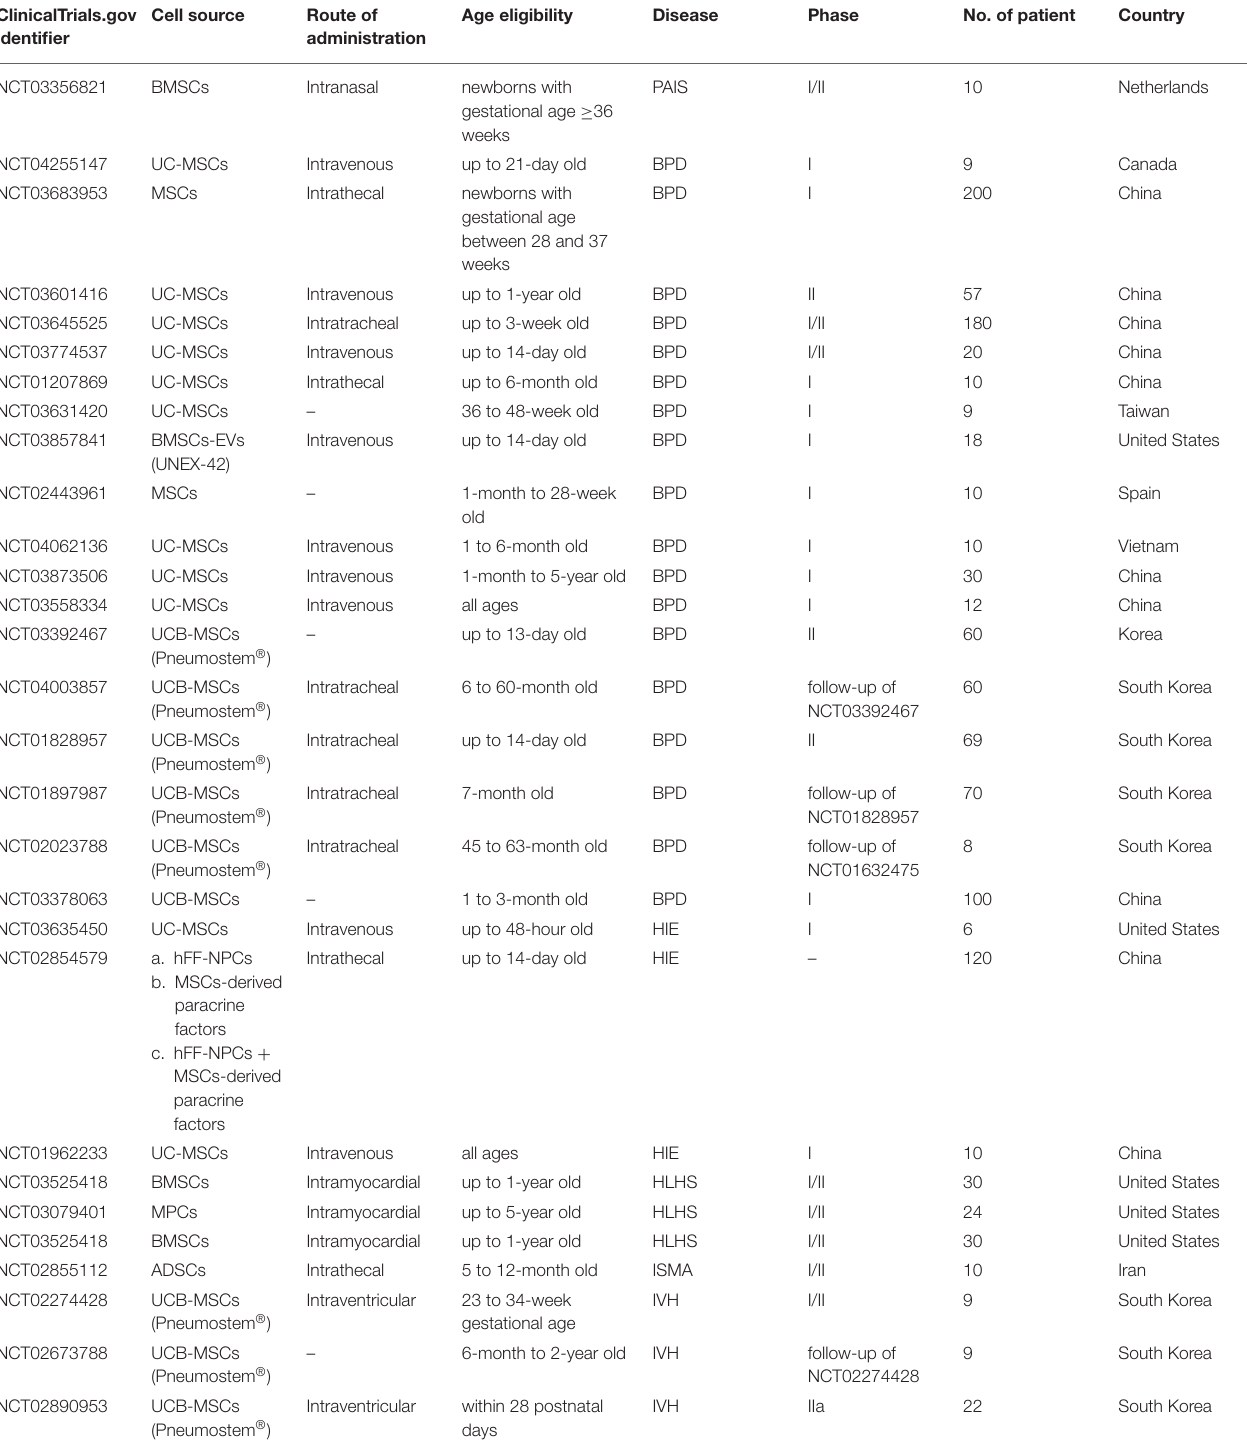
TABLE 3 | Clinical trials using MSCs to treat neonatal diseases recorded in ClinicalTrials.gov. ClinicalTrials.gov